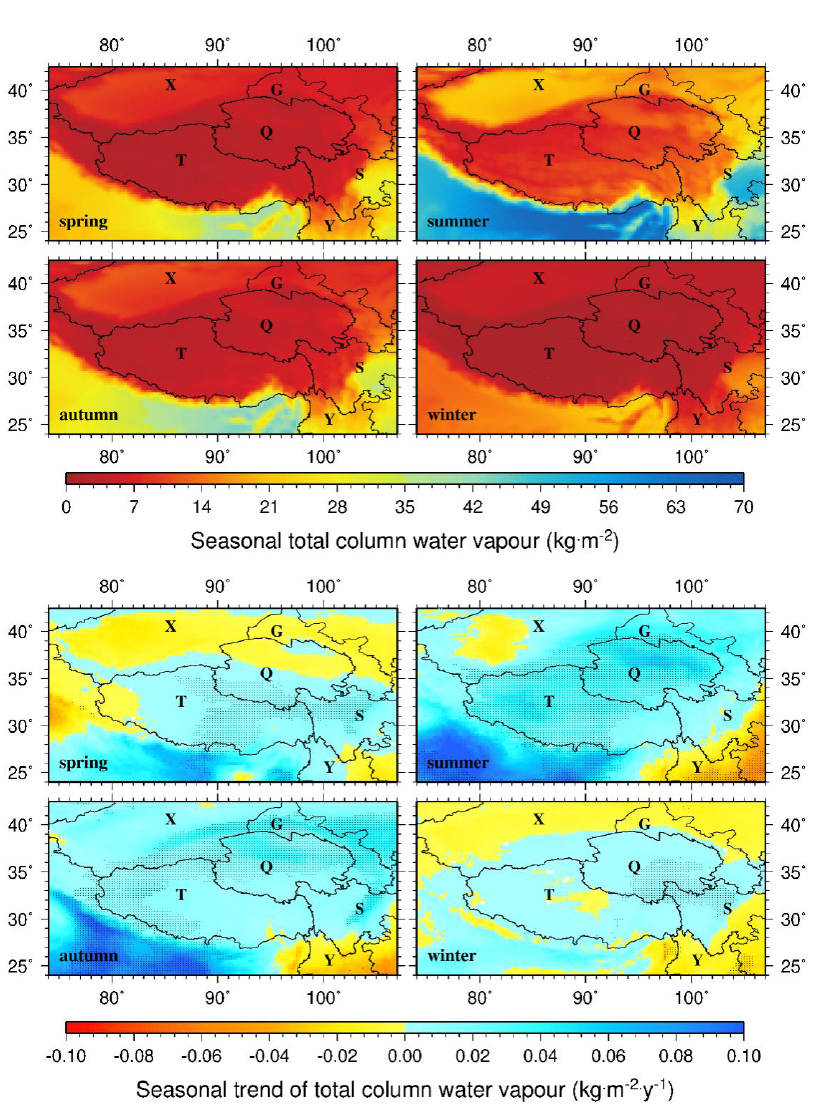
Figure 11. Spatial distributions of the means and trends of ERA5 total column water vapor (TCWV) during 1979–2015. Statistically significant trends ( p < 0.05) are represented by crosses in this figure and the following figures.